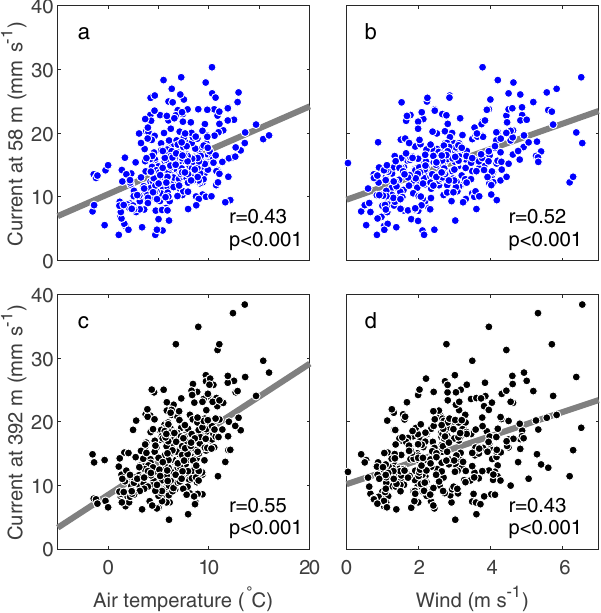
Fig. 5 Correlations between current and AWS data. Scatter plots of daily current speed at the depth of 58 m versus ( a ) air temperature and ( b ) wind speed from July 2017 to 2018. ( c ) and ( d ) are the same plots for current at 392 m. Current and wind speeds were fi ltered with a 1-d window. The grey lines are a linear regression of the data with Pearson correlation coef fi cients r and p